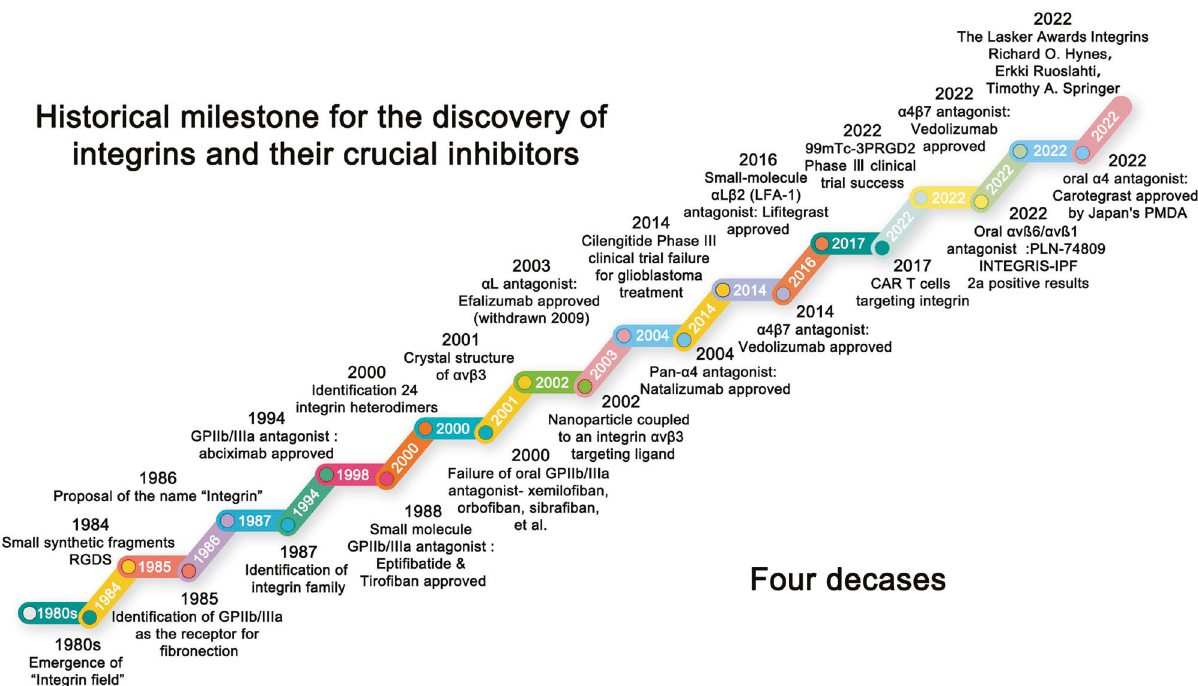
Fig. 1 Timeline of the historical milestone for the study of integrin receptors and their main antagonists and agents in the past four